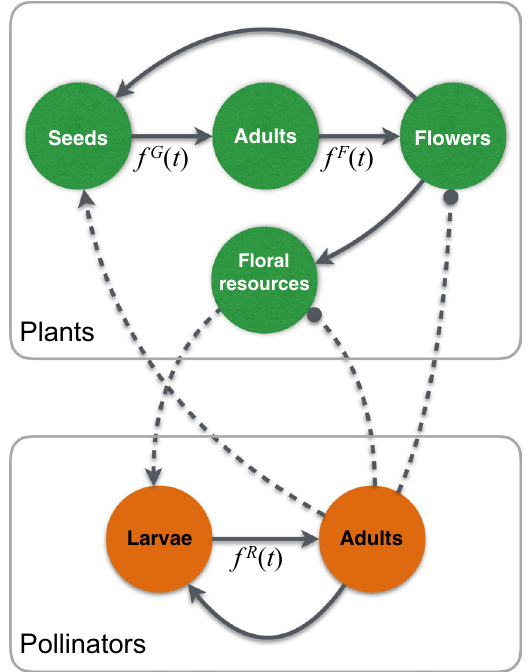
Figure 4. Graphical representation of the basic structure of our dynamic model. Lines ended in arrows/circles indicate a positive/negative effect of one variable on another. Continuous lines indicate life-cycle transitions within a species. Dashed lines represent interactions between plants and their pollinators. Positive effects compose the classically depicted mutualistic interaction. Negative effects arise by pollinators’ flower exploitation (see text for details). Self-effects not shown to keep simplicity. Those transitions marked with f ( t ) are governed by time-dependent (i.e. phenological) functions. In these functions, superscripts g , f and r represent germination, flowering and pollinator recruitment,